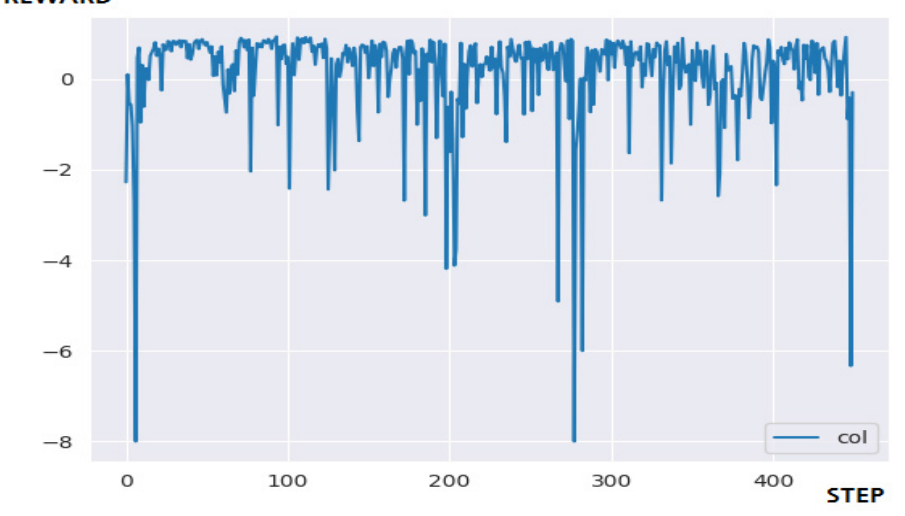
Figure 9. The result of a 5 × 5 maze game through DQN.